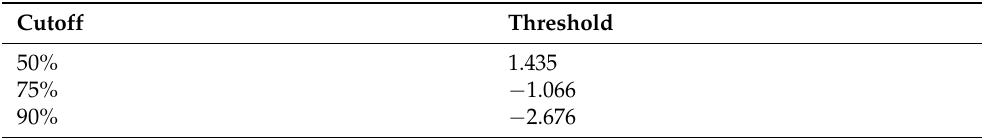
Table A6. Externally cross-validated thresholds for naive Bayes classification. Scores above the threshold mean low risk, below the